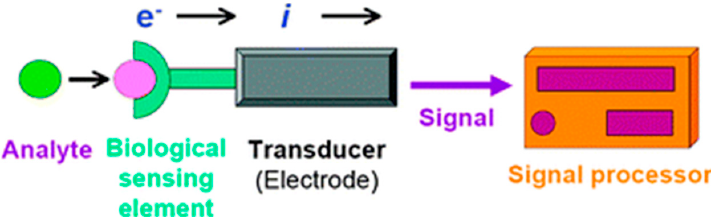
Figure 1. Scheme of a biosensor with electrochemical transducer [2]. Copyright 2010. Reproduced with permission from The Royal Society of Chemistry.